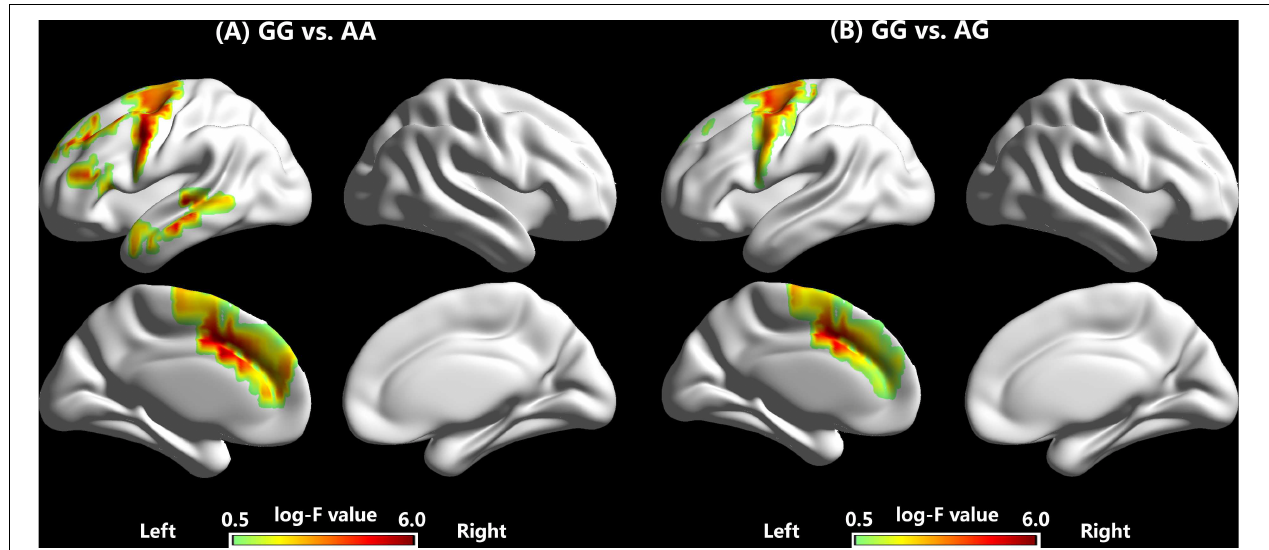
FIGURE 5 | Source reconstructions of the amplitudes of P2 responses to –200 cents pitch perturbations, showing enhanced brain activity in the P2 time windows for individuals with the GG genotype when compared to individuals with the AA (A) and AG (B) genotypes.